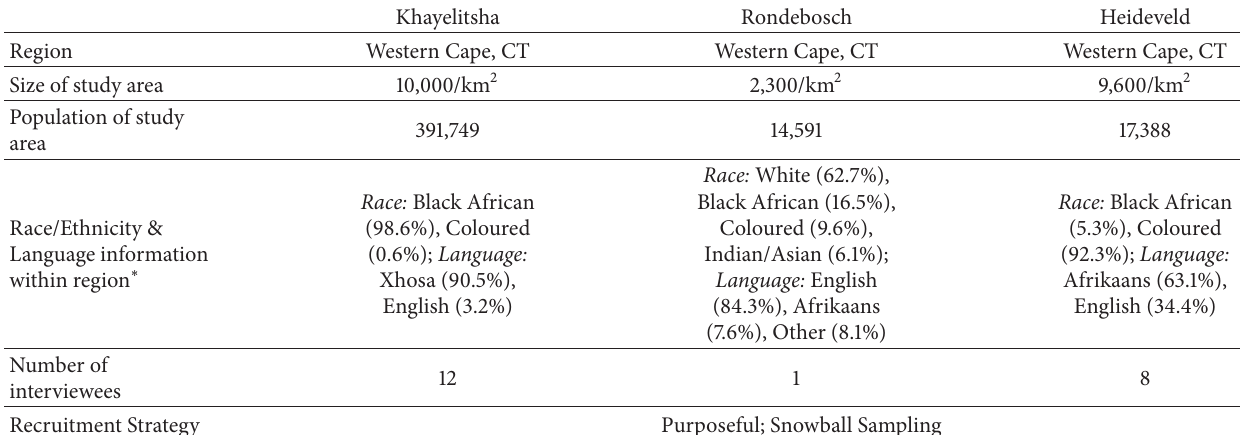
Table 1: Key characteristics of study sites in Cape Town, South Africa.